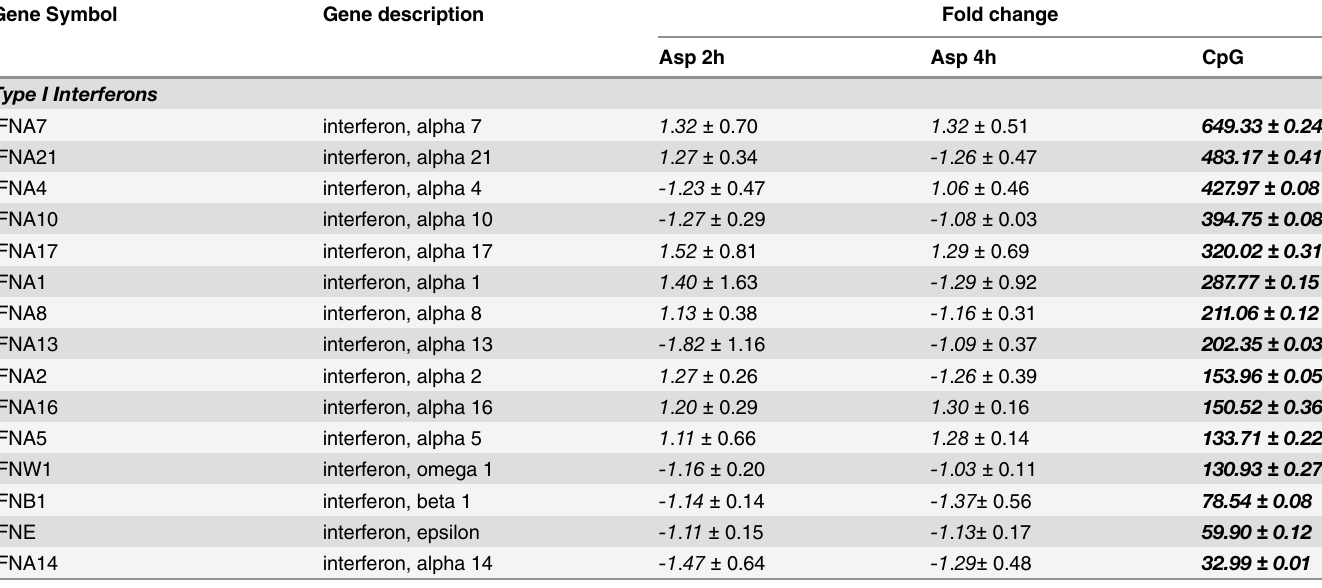
Table 2. Genes encoding type I